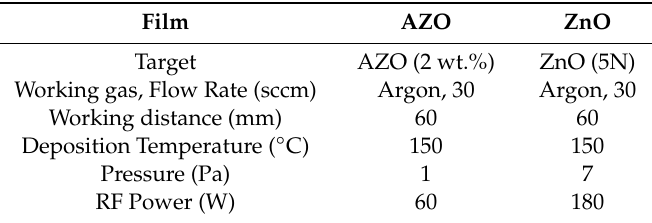
Table 1. Deposition conditions of AZO and ZnO films.